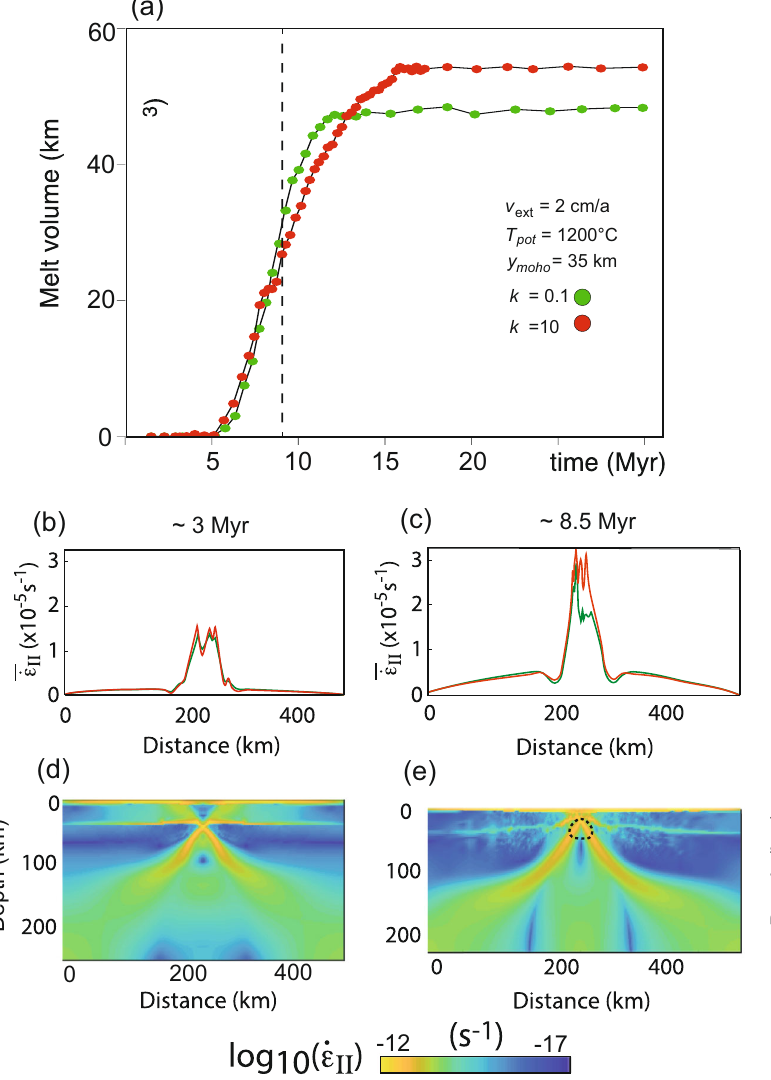
Fig. 6 | Thermomechanically coupled numerical simulation of continental extensionwithparametersadjustedtore fl ecttheRedSeaopening. Theresults are for an extension rate of v ext =2cm per year, a potential mantle temperature T pot =1200°C and a Moho depth of y moho =35km as well as two different effective erosional diffusivities k . Shown time steps correspond to million years after rifting and thus correspond in the Red Sea region to about 10Ma and the Pliocene after